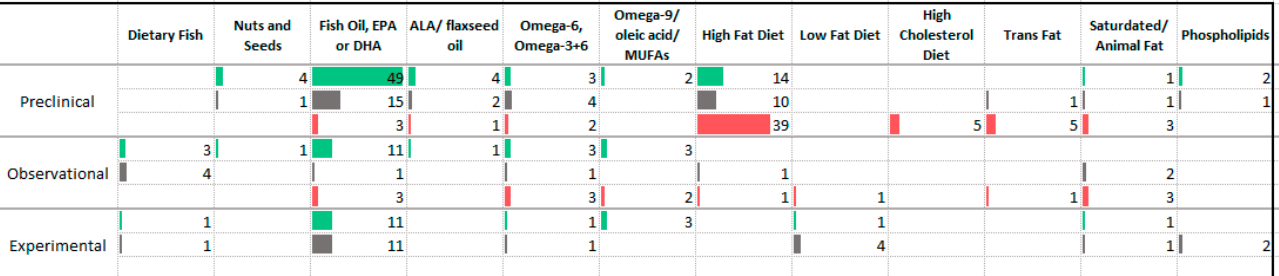
Figure 9. Studies assessing dietary fats and anxiety. █ Higher intake or levels associated with decreased anxiety. █ No association between intake or levels and anxiety. █ Higher intake or levels associated with increased anxiety.